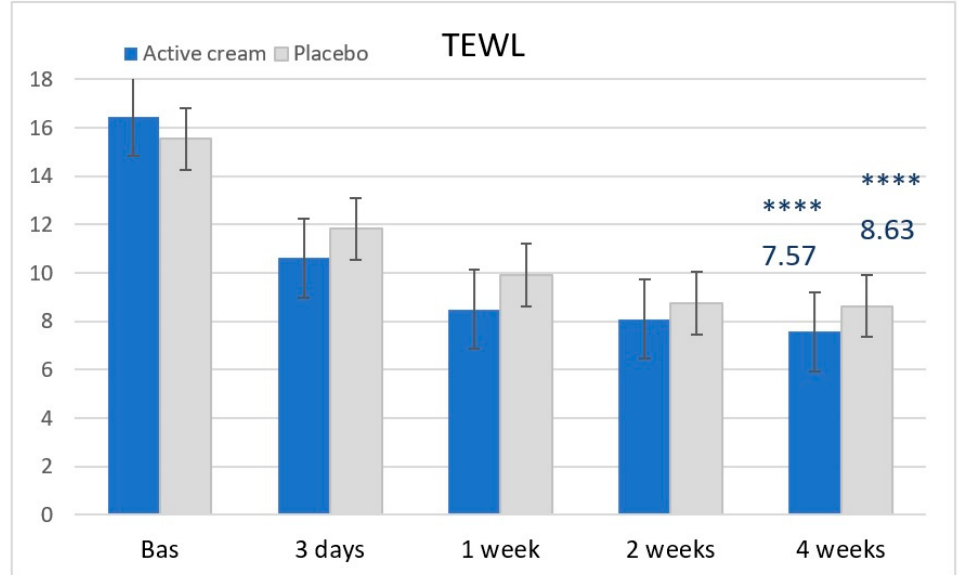
Figure 2. Transepidermal water loss (TEWL) values (mean + SD) show a reduction of − 54% in the hydrogel (with 2% of ceramides and trehalose based ingredient) site after 4 weeks (**** p < 0.01 ( t -test); n = 15 subjects; Bas = Baseline, T0; 4 weeks = after 4 weeks of application).